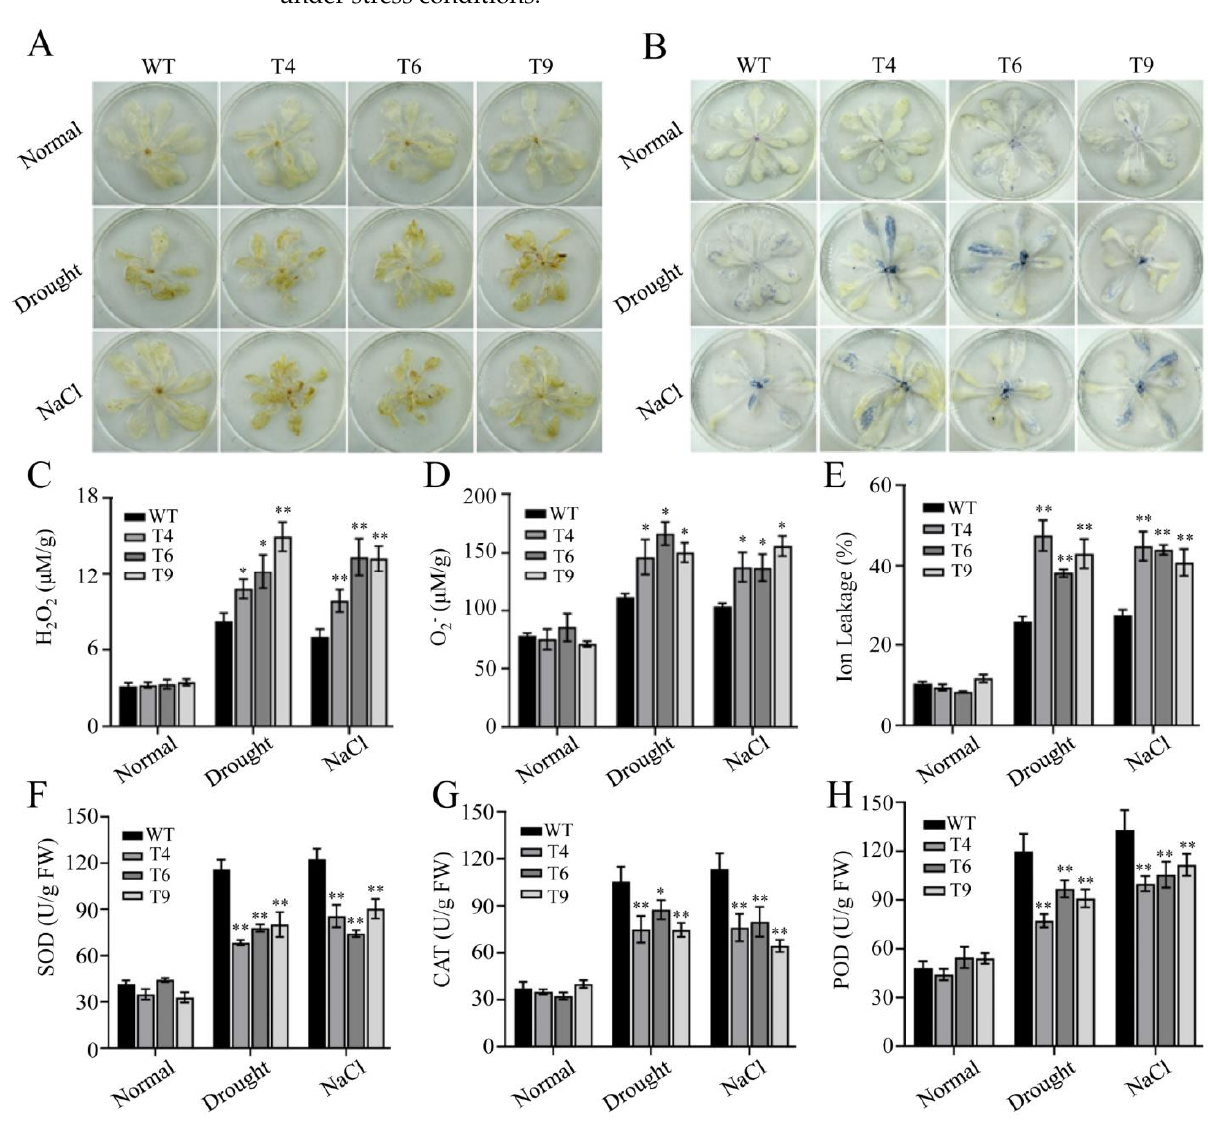
Figure 9. Peroxide staining and the peroxidase activity in FtMYB22 transgenic Arabidopsis (T4, T6, and T9) lines and WT lines under stress treatments as indicated. ( A ) DAB staining. ( B ) NBT staining.